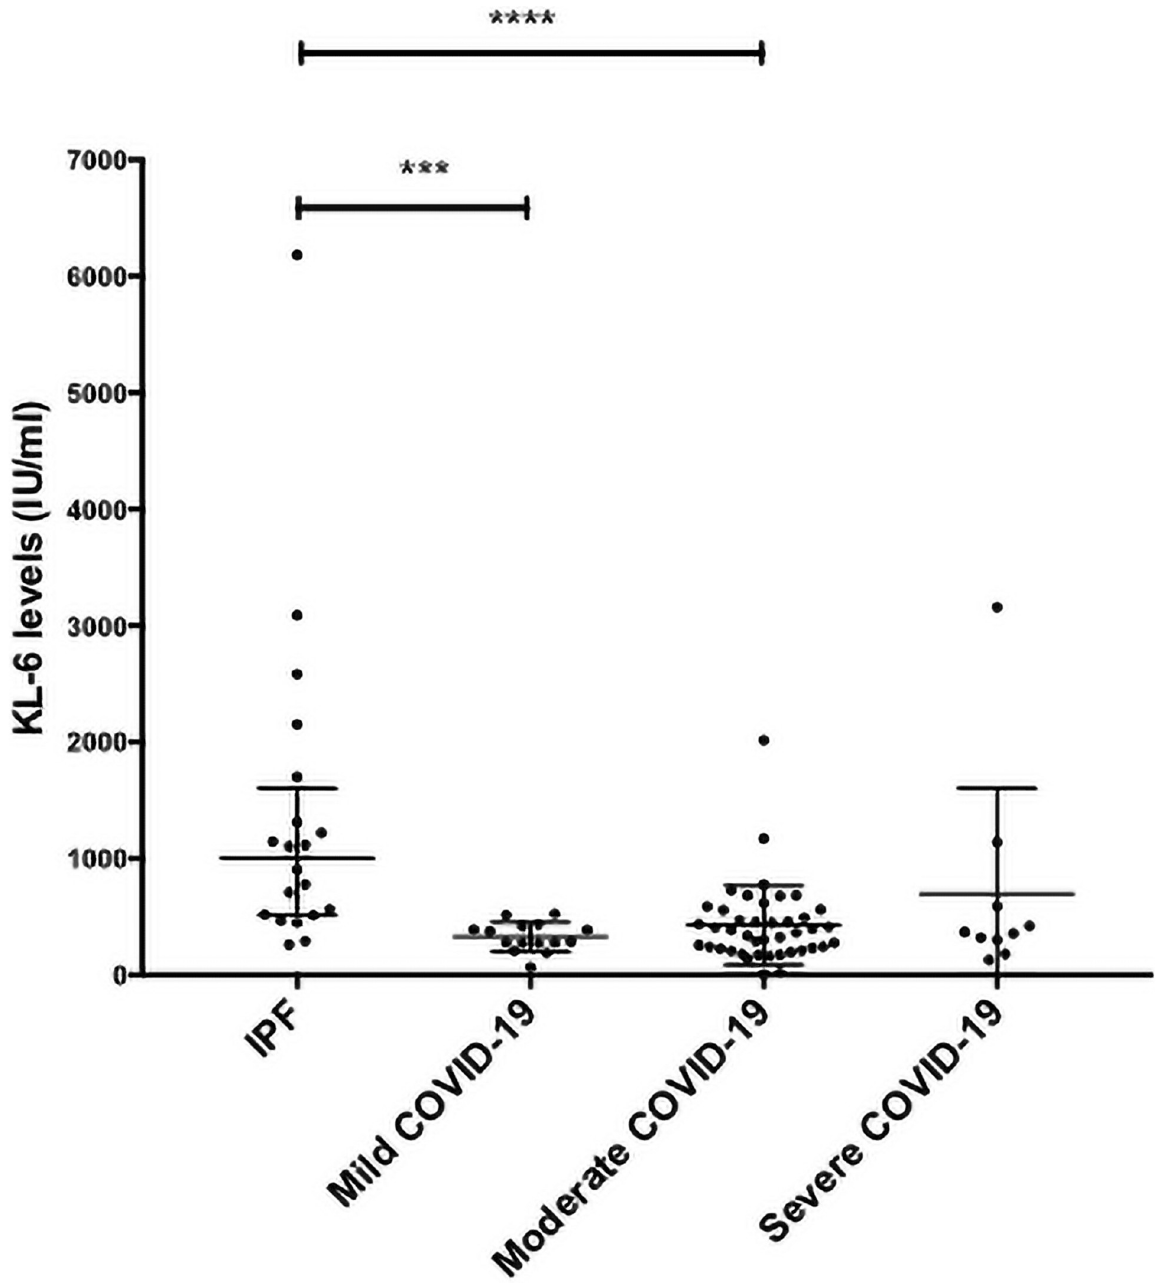
Fig 2. Serum Krebs von den Lungen (KL-6) levels in COVID-19 patients according to disease severity at 28 days following admission and compared to a population of patients with Idiopathic Pulmonary Fibrosis (IPF). There was no statistical difference in the baseline KL-6 and the severity of the acute infection as measured at 28 days (Kruskal-Wallis, p > 0.05). KL-6 levels in patients with mild-moderate IPF were statistically higher than those with mild ( ��� p < 0.001) or moderate COVID-19 ( ���� p < 0.0001).